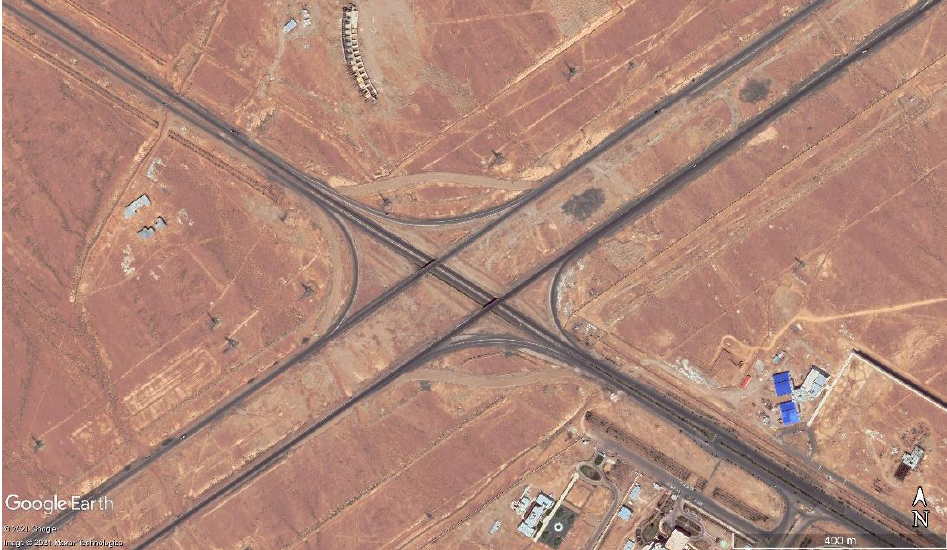
Figure 9. The bridge No. 2 on Google Earth (Latitude: 36°10′35″ N, Longitude: 54°18′17″ E).